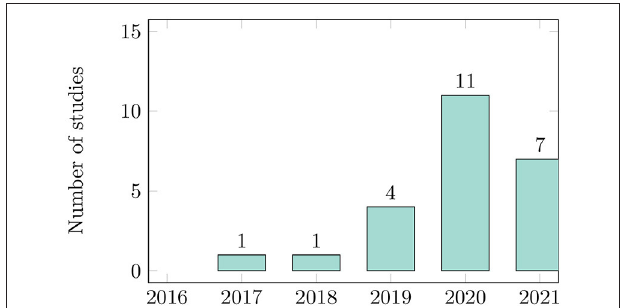
FIGURE 3 | Number of studies per year of publication. In 2021, we only reviewed publications up to September